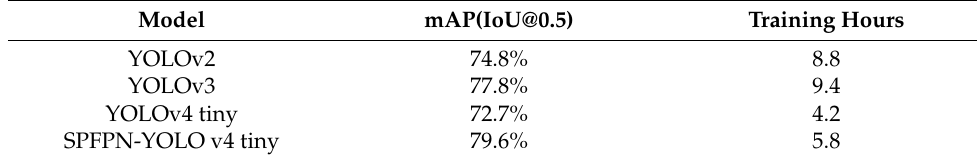
Table 5. mAP(IoU = 0.5) comparison with various YOLO models.